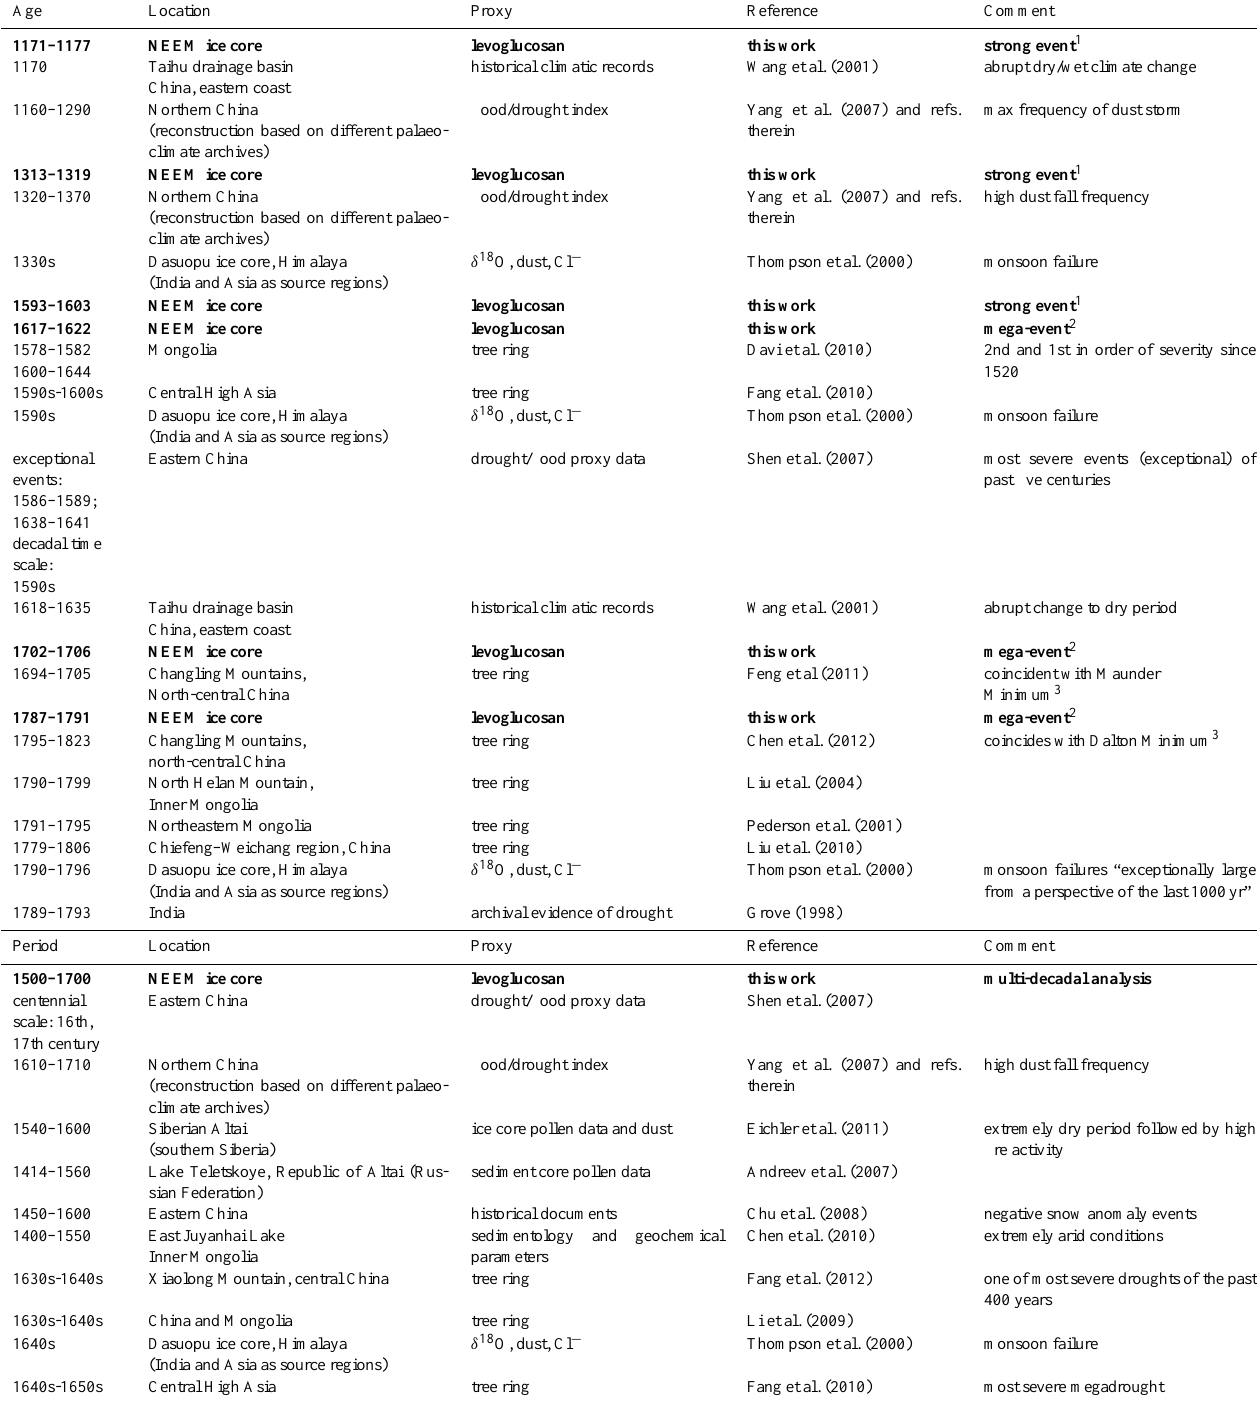
Table 2. Asian droughts recorded in various proxies with strong fire events (a) and with centennial fire activity in the 16th and 17th century inferred from levoglucosan analysis (b)